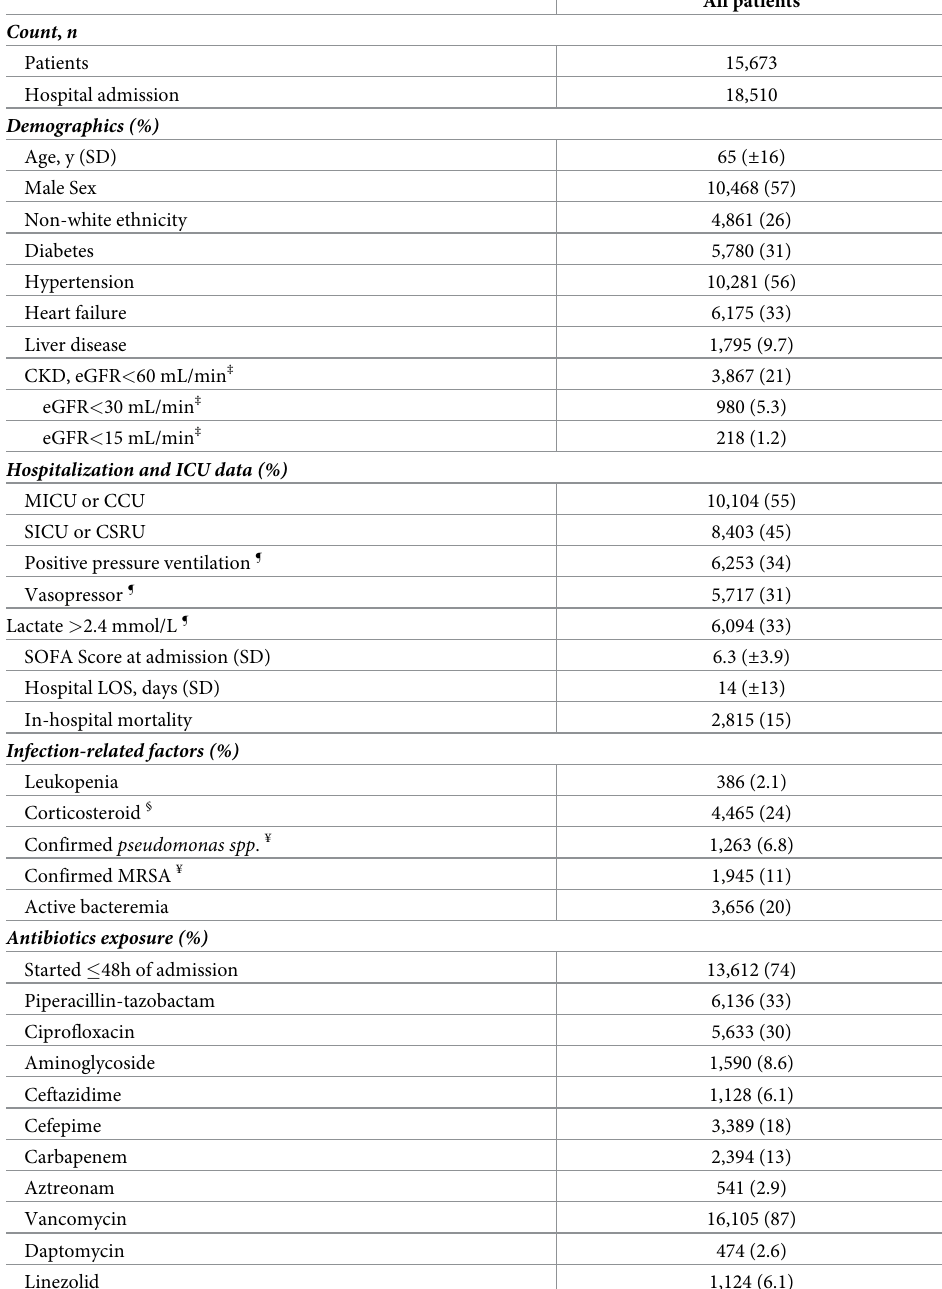
Table 1. Baseline characteristics of included patients †